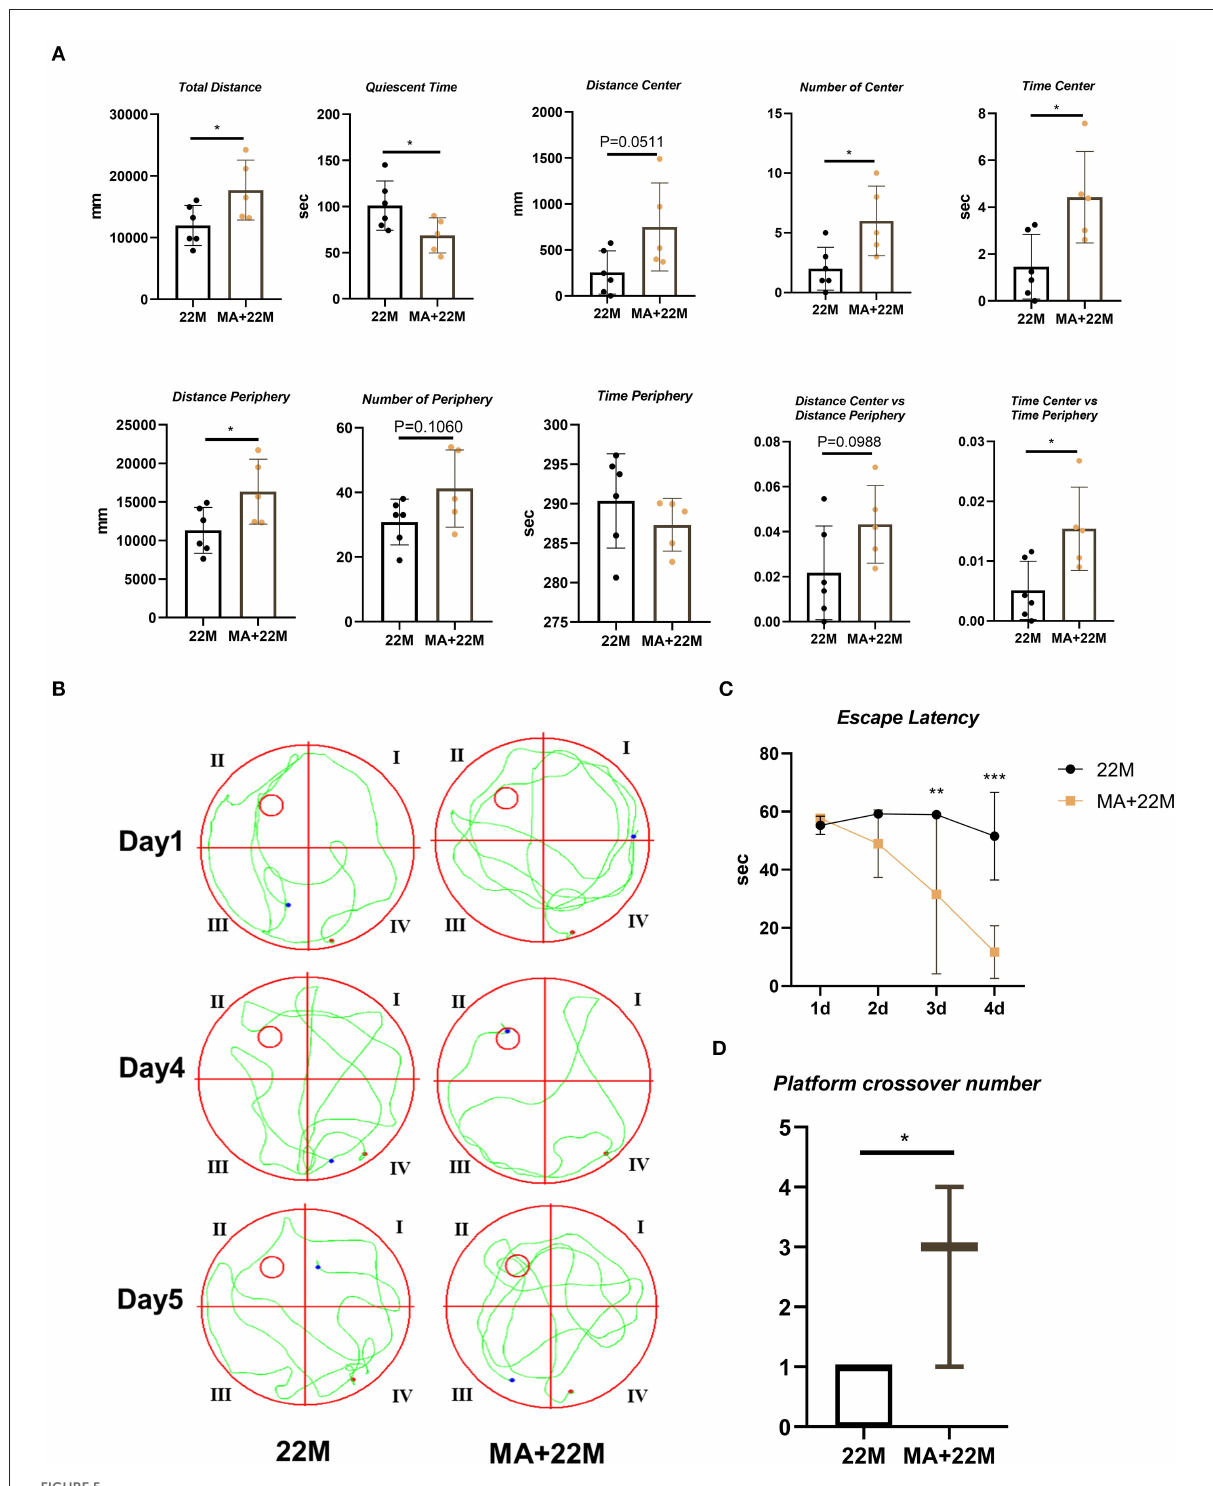
FIGURE5 Evaluation of exploration and spatial memory ability in MA-treated aging mice. (A) The parameters of open field test between aging mice (22M) and MA-treated aging mice (MA + 22M) group. Data were represented as mean ± SD and were analyzed by Student t -test. * P < 0.05. (B) The locus diagrams of Morris water maze between 22M and MA + 22M group. Day 1th and Day 4th, Navigation test; Day 5th, Space exploration test. (C) Escape Latency in the navigation test of Morris water maze between 22M and MA + 22M group. Data were represented as mean ± SD and were analyzed by two-way ANOVA following Bonferroni’s multiple comparisons test. ** P < 0.01 and *** P < 0.001. (D) Platform crossover number in the space exploration test of Morris water maze. Mann-Whitney U test was employed and a box plot was used. * P <